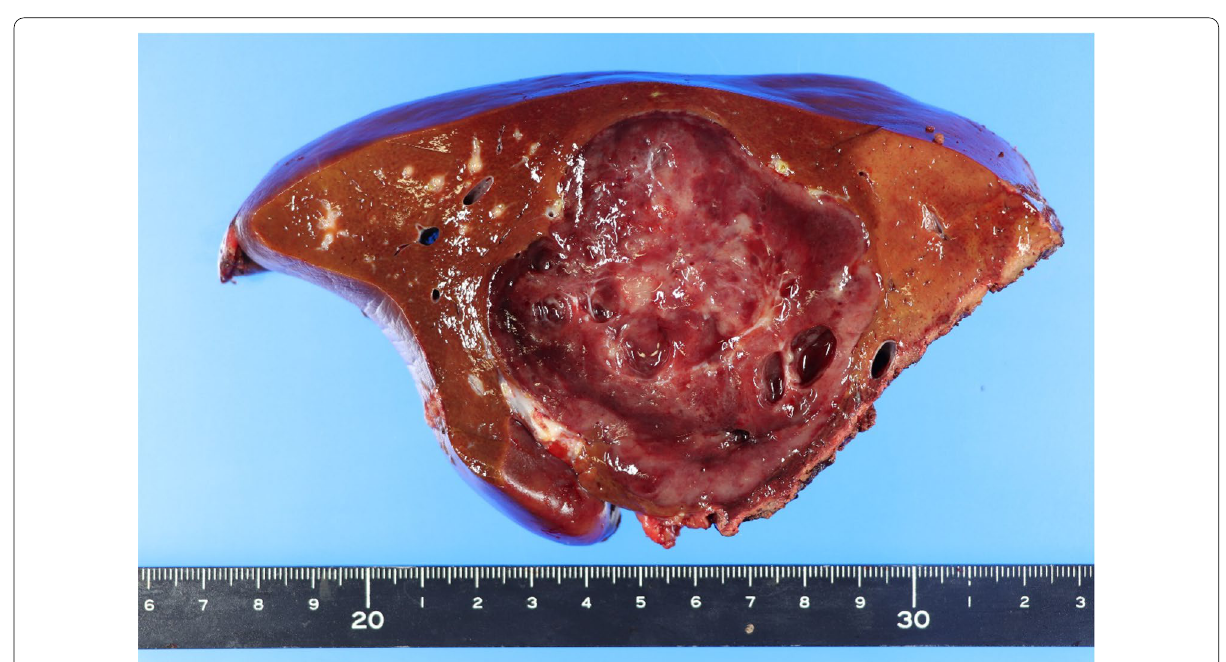
Fig. 3 Macroscopic findings of the resected specimen. The solid mass with cystic degeneration (73 mm in diameter) was